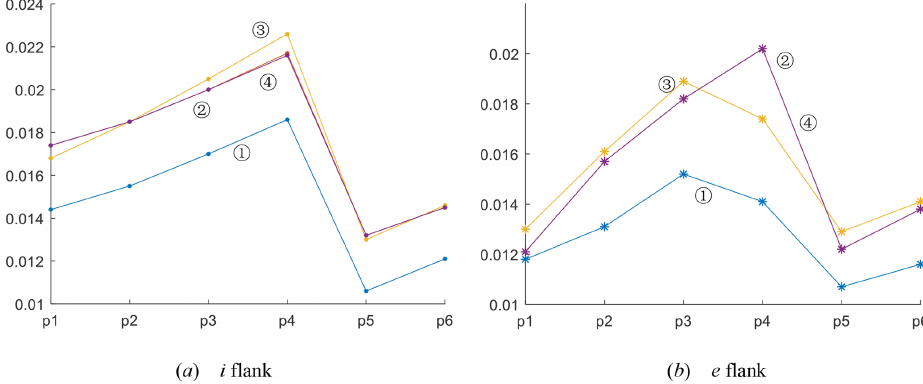
Figure 9. Numerical variation of the induced principal curvature at the observation points.